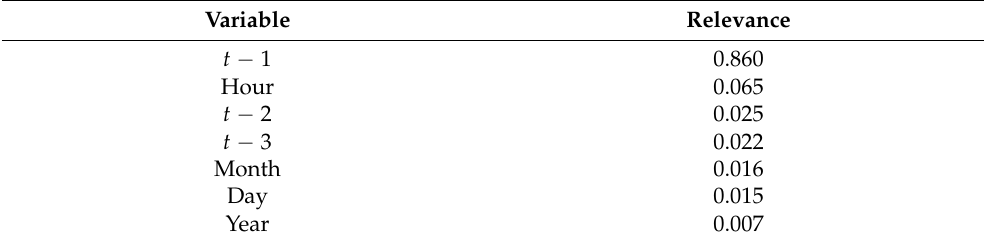
Table 2. Relevance of each variable.